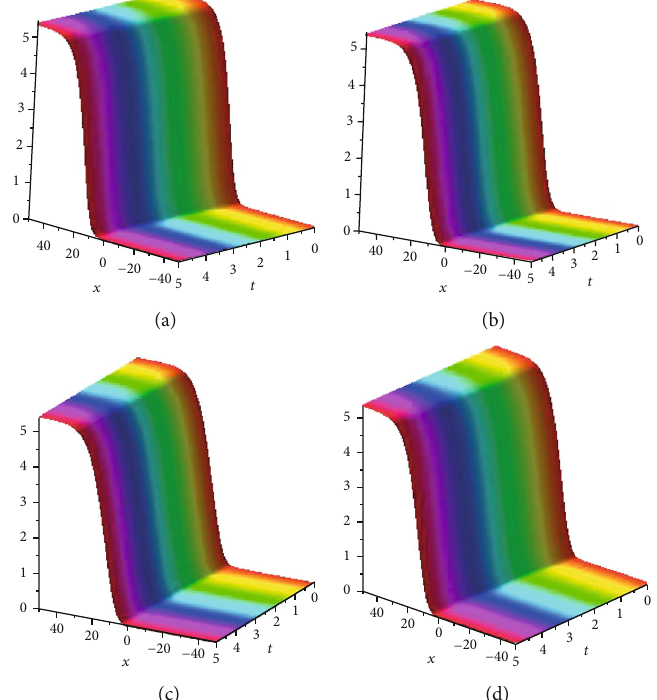
= 1 : 5 , r = 2 , λ = 2 : 2 , and k = 3 when (a) α = 0 : 25 , (b) α = 0 : 5 , (c) α = 0 : 85 , and (d) α = 0 : 99 . 2 2